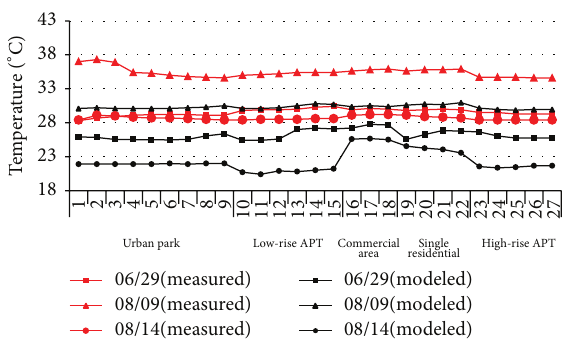
Figure 4: Comparison of modeled and measured temperatures at each measurement point.